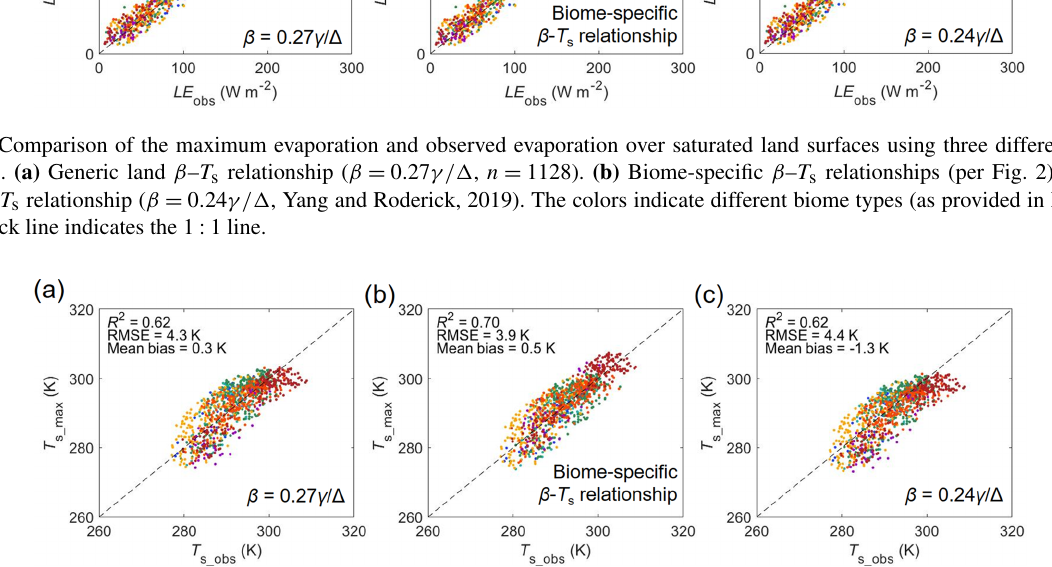
Figure 5. Comparison of the estimated and observed surface temperature over saturated land surfaces using three different β – T s relationships. Comparison of estimated surface temperature ( T s_max ) with flux site observations ( T s_obs ). (a) Generic land β – T s relationship ( β = 0 . 27 γ/(cid:49) , n = 1128). (b) Biome-specific β – T s relationships (per Fig. 2). (c) Ocean surface β – T s relationship ( β = 0 . 24 γ/(cid:49) , Yang and Roderick, 2019). The colors indicate different biome types (as provided in Fig. 1). The dashed black line indicates the 1 : 1 line.